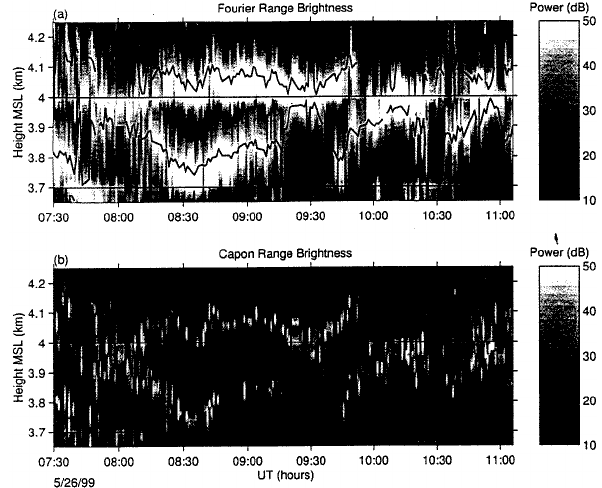
Fig. 8. Time variations of brightness distribution within two succes- sive 300-m range gates estimated from a multi-FDI technique with the Sousy radar, (four frequencies between 53.25 and 53.75 MHz) during the SOMARE99 campaign and using (top) Fourier Based imaging and (bottom) Capon’s method. The position given by dual FDI is shown by the black line. Thin echoing layers and their verti- cal displacements are clearly described with Capon’s method. How- ever, as in Luce et al. (2000a), the HR techniques did not reveal more complex structures than a single echoing layer in spite of their potentialities to distinguish several structures (after Palmer et al.,